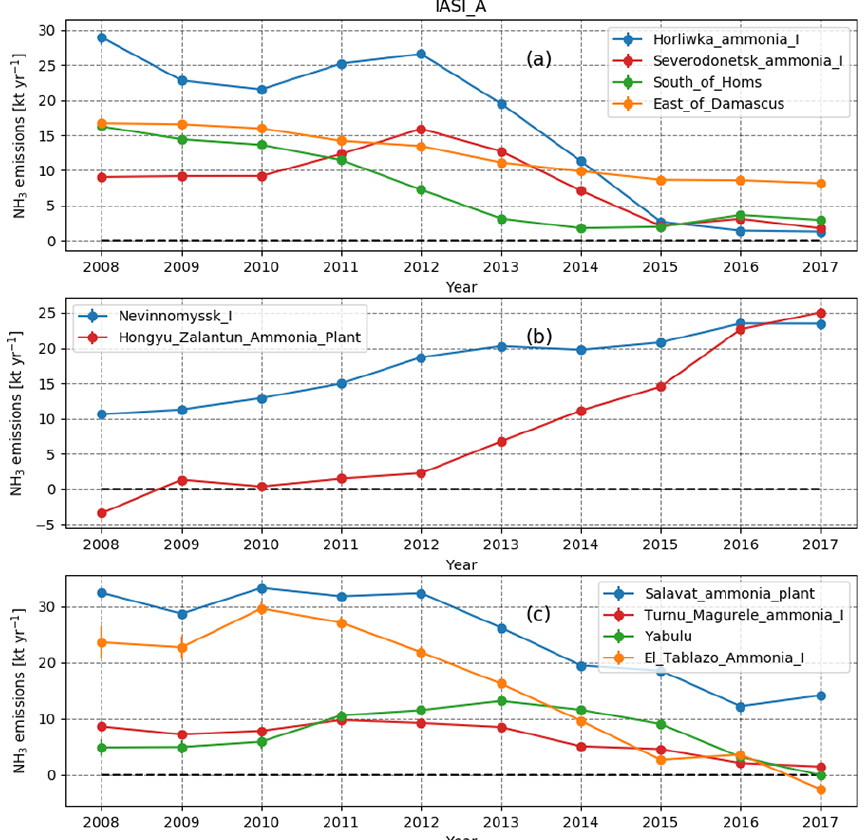
Figure 11. Annual variations in the IASI-A NH 3 emission estimates for (a) sources in conflict zones, (b) industrial sources that increased production and (c) industrial sources that reduced